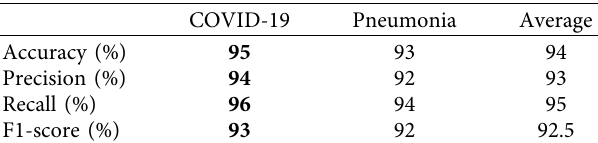
Table 6: Estimated performance metrics for the